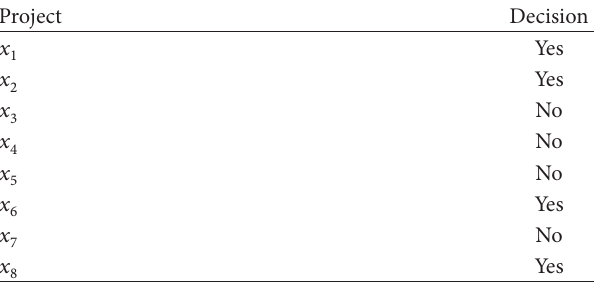
Table 2: A system about emporium investment